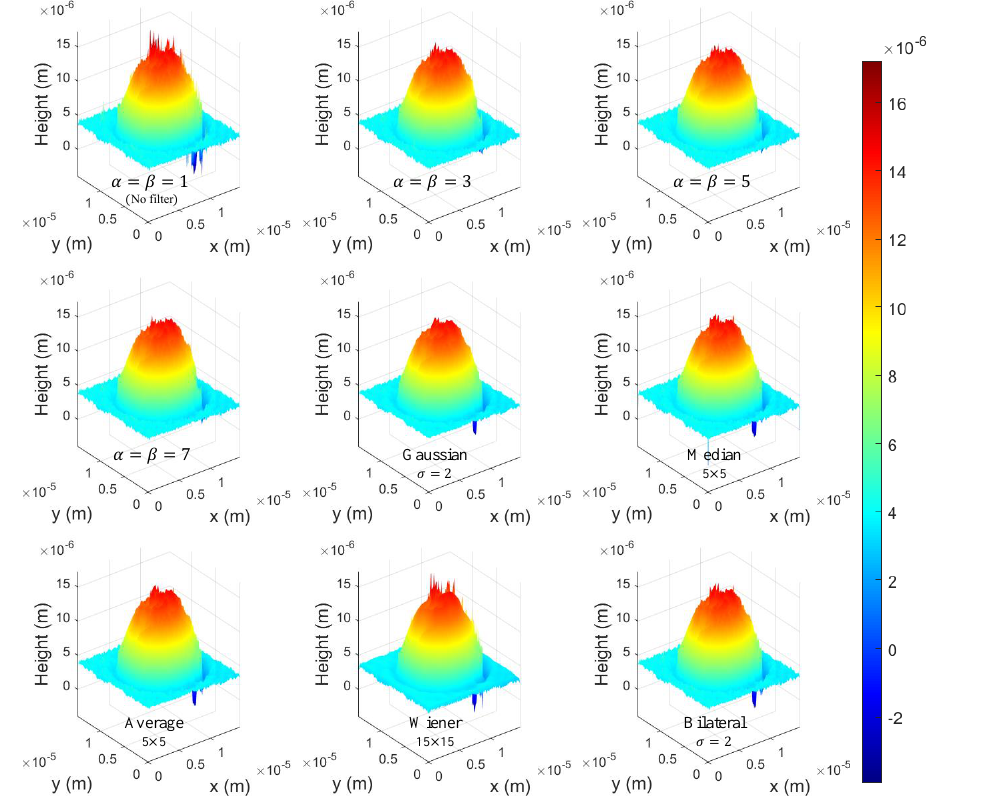
Figure 7. 3D height profile results by various filters.